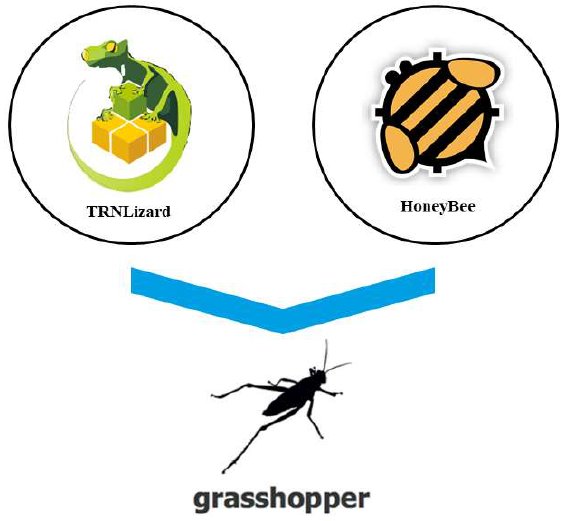
Figure 1. Graphic illustration of the simulation methodology (own